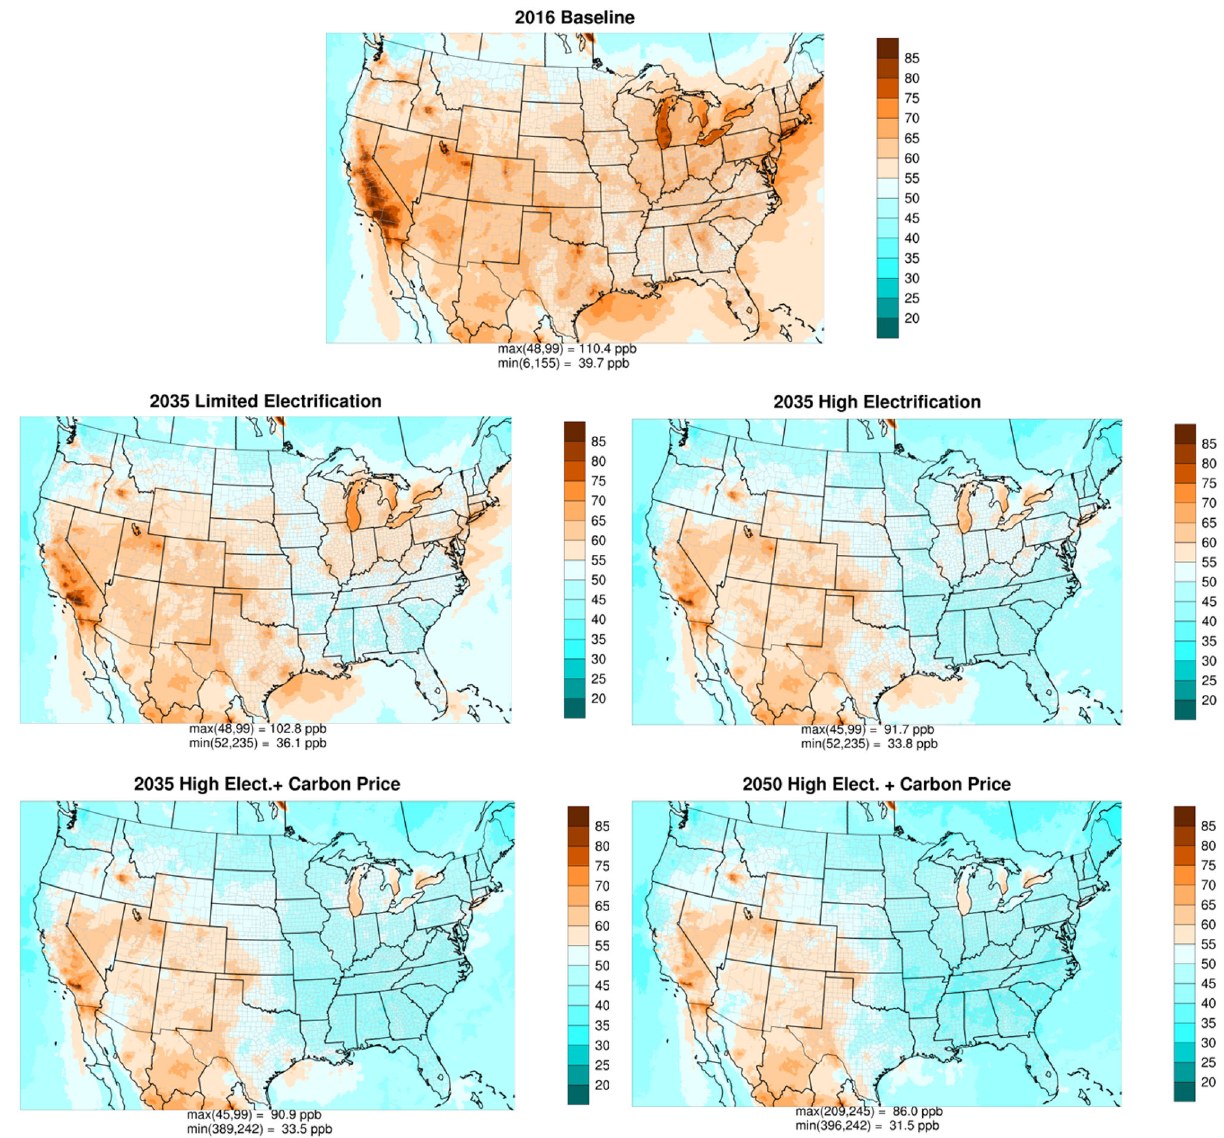
Fig.2|Estimatedozonedesignvalues(inpartsperbillion,ppb)throughoutthe Continental U.S. The design value metric under the U.S. National Ambient Air QualityStandards(NAAQS)isthefourthhighestmaximumdaily8-haverageozone